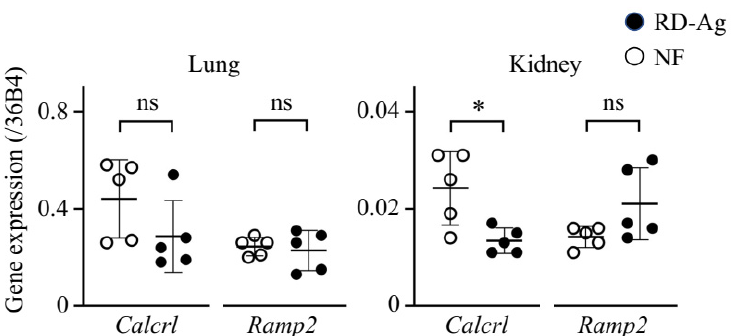
Figure 2. Downregulation of GPCR Calcrl gene expression in mercury chloride-treated rats with impaired renal function. Changes in Calcrl (calcitonin receptor-like receptor) and Ramp2 (receptor activity modifying protein 2) mRNA measured by qRT-PCR in the lungs and kidneys of rats with renal dysfunction induced by mercury chloride treatment (RD-Ag, n = 5) and normal renal function rats (NF, n = 5). Mann-Whitney u test, * p < 0.05; ns, not significant. Bars represent means ±